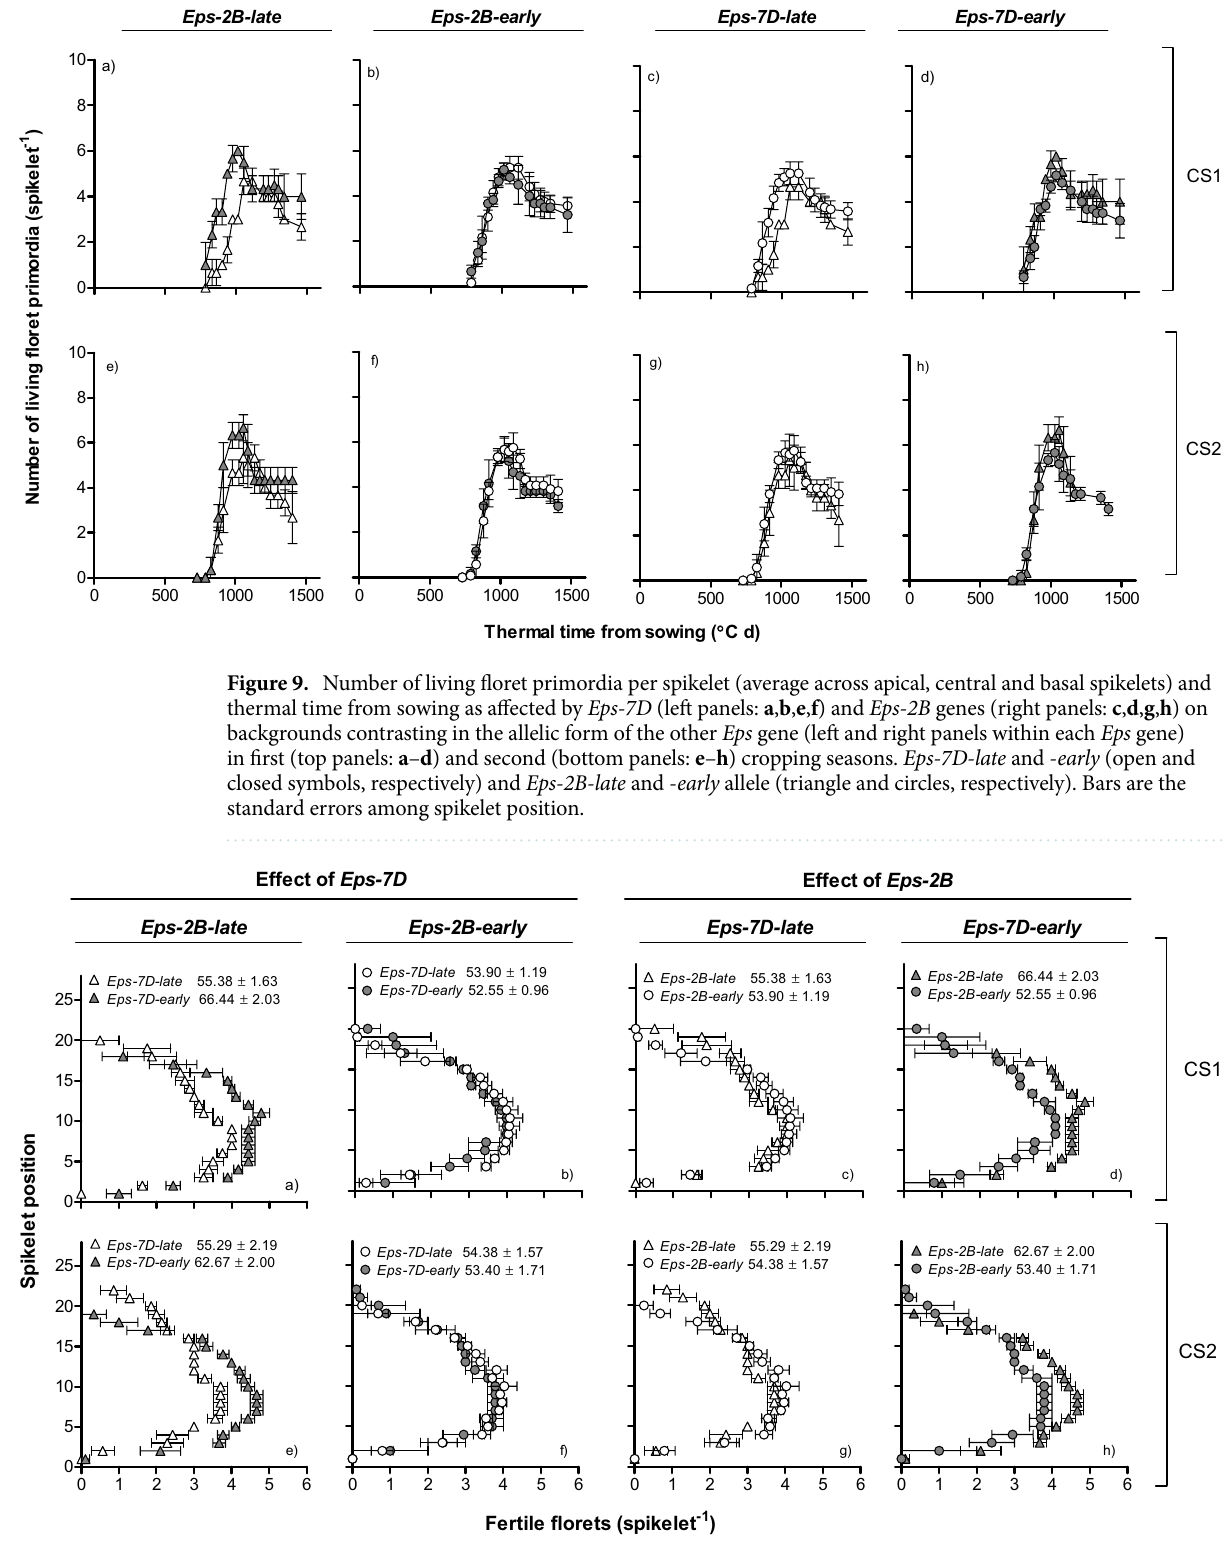
Figure 10. Mapping of fertile florets at anthesis per each spikelet in the spike as affected by Eps-7D (left panels: a , b , e , f ) and Eps-2B genes (right panels: c , d , g , h ) on backgrounds contrasting in the allelic form of the other Eps gene (left and right panels within each Eps gene) in first (top panels: a – d ) and second (bottom panels: e – h ) cropping seasons. Inside each of the panels are the fertile florets per spike with